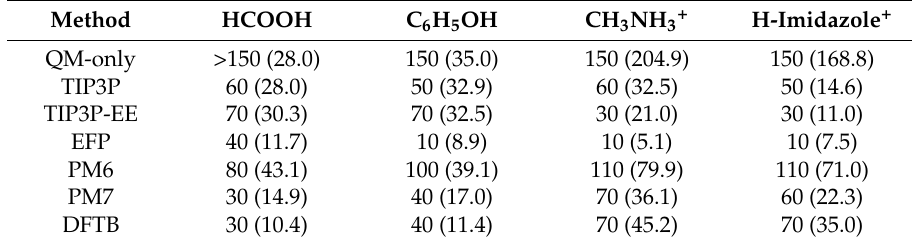
Table 2. The minimal quantum mechanics (QM) region size ( m ) needed to approach within 10 kJ mol − 1 of the pure QM result on the full system (160-water cluster). Values in parenthesis refer to error associated with smallest ( m = 10) QM region.